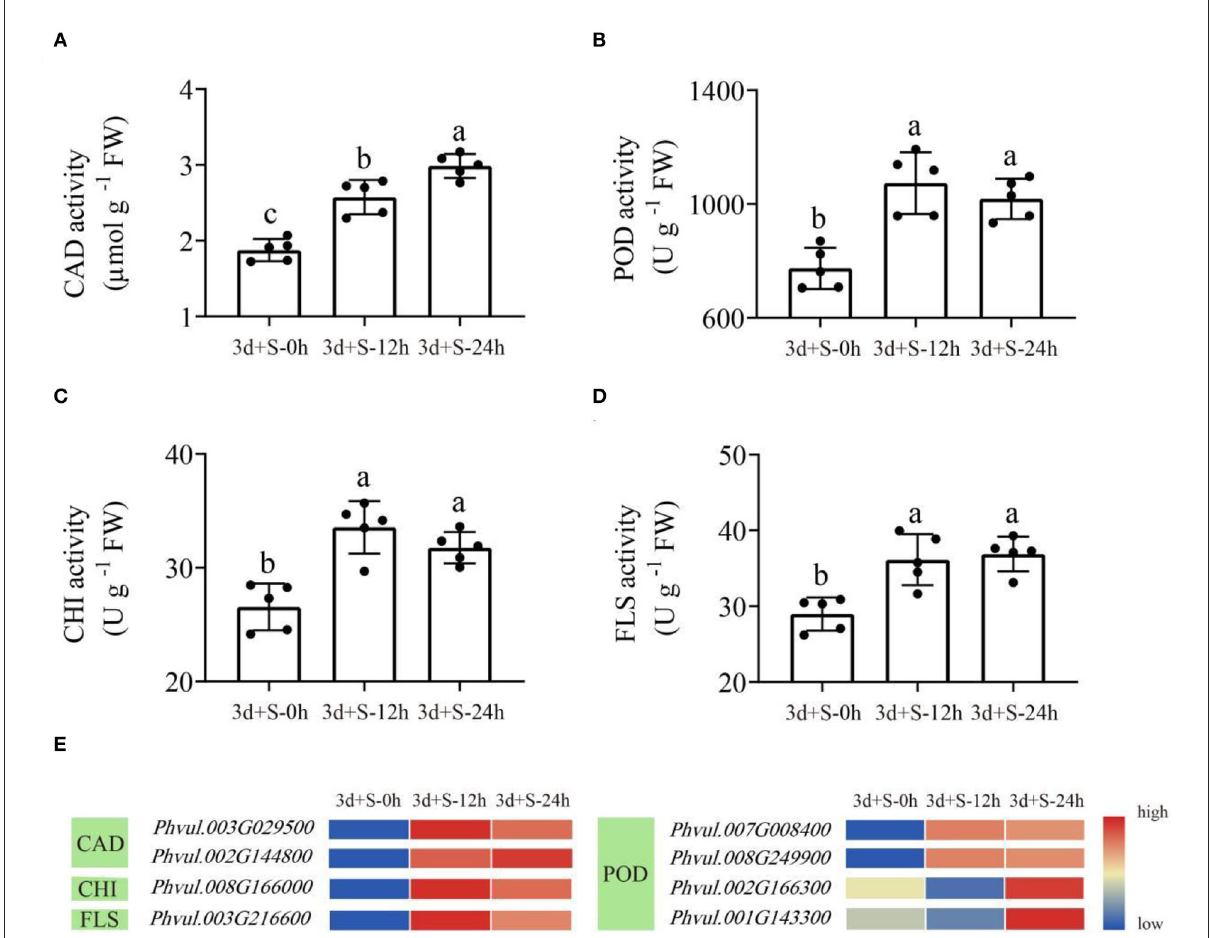
FIGURE6 The enzyme activities in the enriched pathways at three time points. Lowercase letter(s) indicate significant differences ( α = 0.05). Each black point represents the average value of replicates. (A) CAD activity; (B) POD activity; (C) CHI activity; (D) FLS activity; (E) the heatmap of differentially expressed genes (DEGs) enriched in these four enzymes. Blue to red color represents low to high expression.